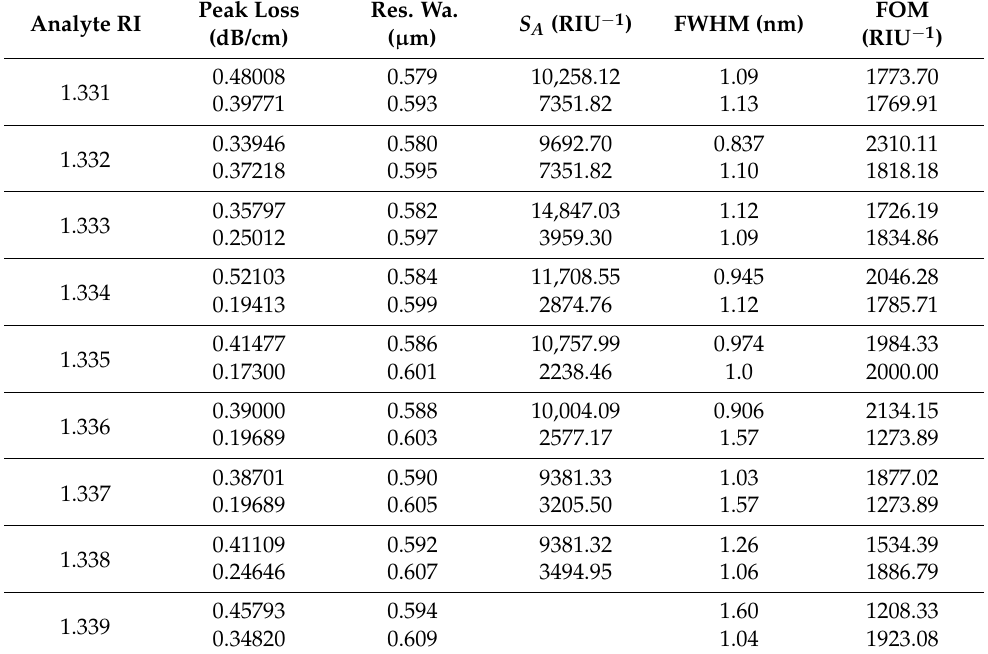
Figure 4. Comparison of the sensitivity for x and y polarization when the analyte refractive index is varied from 1.331 to 1.339. The thickness of the graphene layer is 36.72 nm.